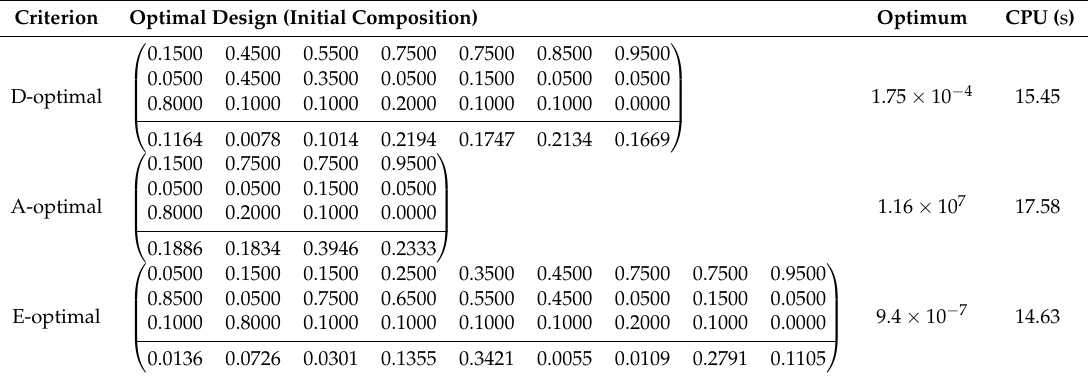
Table 3. Optimal experimental designs for ternary system WAT-TCE–KET (initial mixtures).